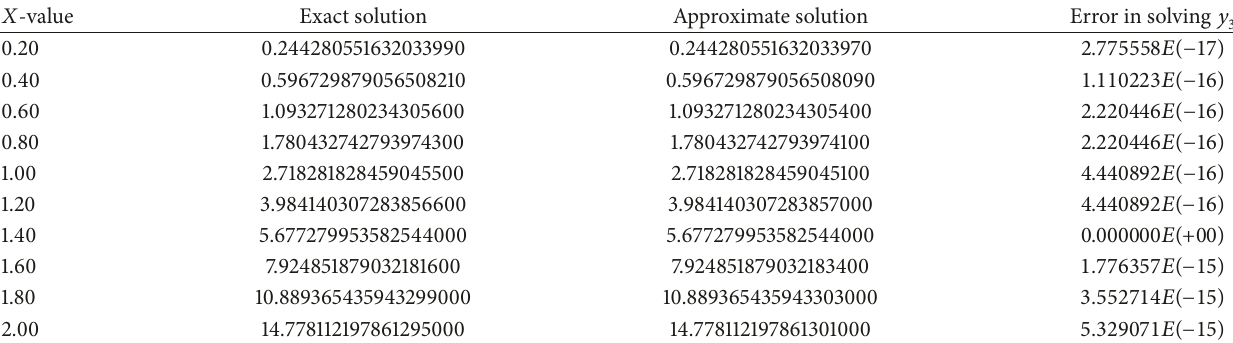
Table 7: Exact and approximate solutions for solving 𝑦 3 using the developed method.